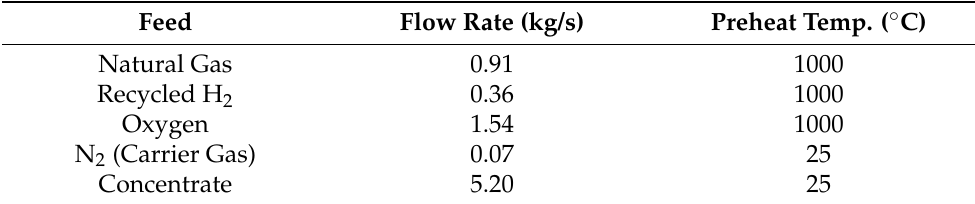
Table 6. Operating conditions for solid product with input gases preheated to 1000 ◦ C.